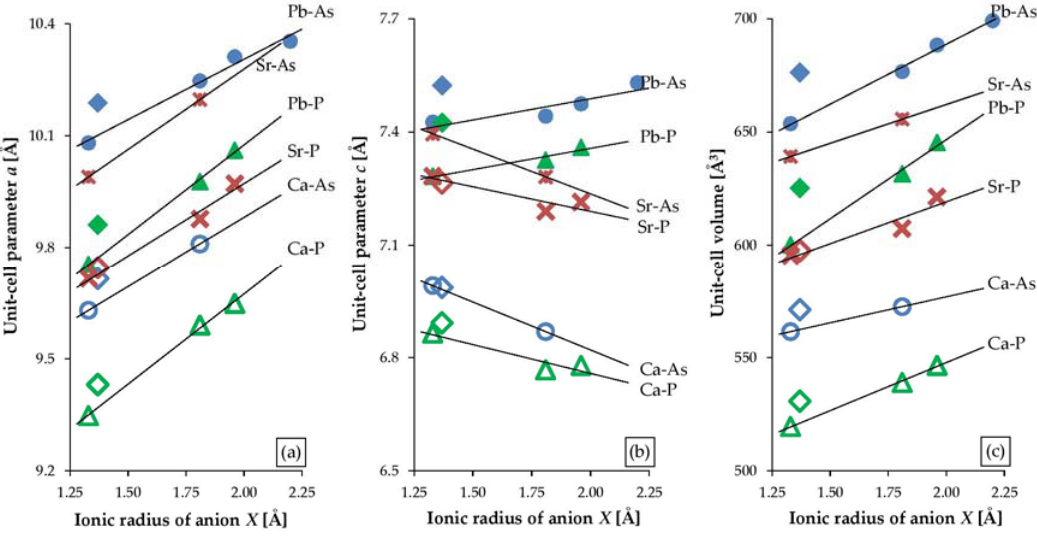
Figure 5. Variations in the unit-cell parameters of substituted apatites based on the results of this study and existing literature ([11,68–73] and ICDD cards no. 23-0112 and no. 38-0383): ( a ) unit-cell parameter a , ( b ) unit-cell parameter c , and ( c ) unit-cell volume, compared with a substituting anion’s ionic